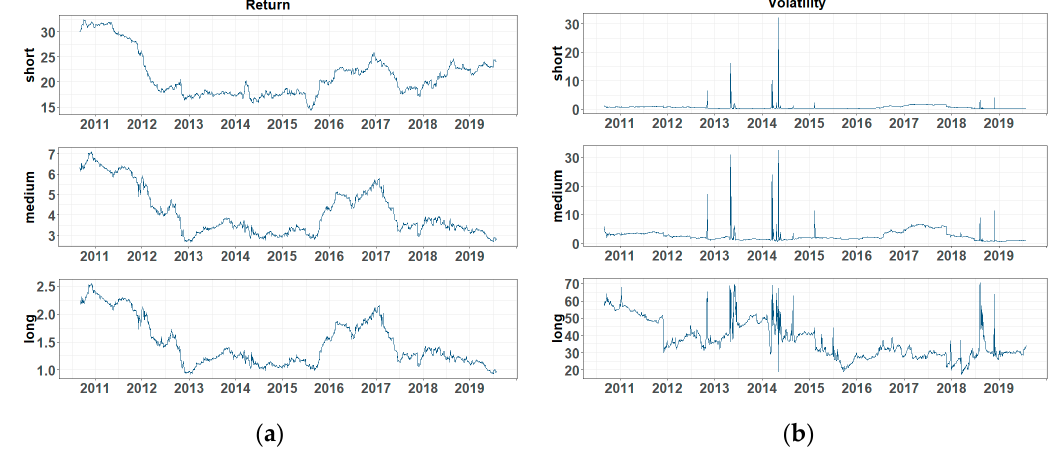
Figure 4. Frequency decomposition of dynamic connectedness: ( a ) frequency decomposition of total connectedness for return series and ( b ) frequency decomposition of total connectedness for volatilities. Note: BRL, RUB, INR, CNH, and ZAR are Brazilian Real, Russian Ruble, Indian Rupee, offshore Chinese Yuan, and South African Rand, respectively. GASF is the Henry Hub natural gas futures price.